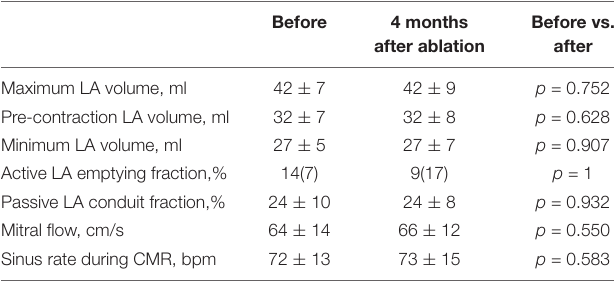
Localized scar in the right pulmonary vein (RPV) neither alters the LA volumes nor alters the global functions (n = 11). One sheep was excluded from the analysis due to artifacts in the cardiac magnetic resonance (CMR) images. The data are expressed as mean ± SD or median (interquartile range) dependent on normality (tested with a Shapiro–Wilk test). Normally distributed data were tested with a paired Student’s t-test and non-normal data with a Wilcoxon signed-rank test.